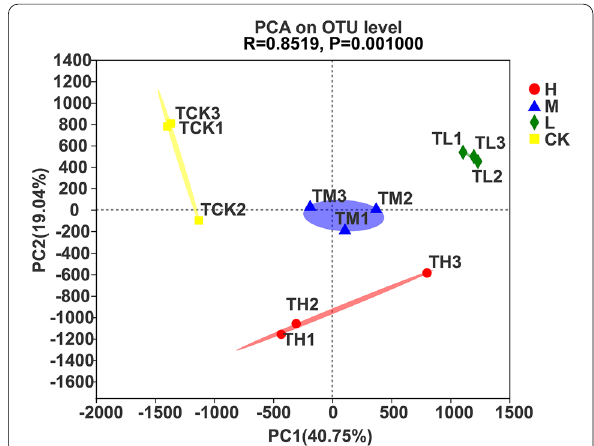
Fig. 5 Principal component analysis of the relative abundance of soil bacteria at the OTU level in sugarcane fields under four N application treatments. H: high N application in the sugarcane soil (964 kg ha − 1 ), M: medium N application in the sugarcane soil (482 kg ha − 1 ), L: low N application in the sugarcane soil (96 kg ha − 1 ), CK: no N application in the sugarcane soil (0 kg ha − 1